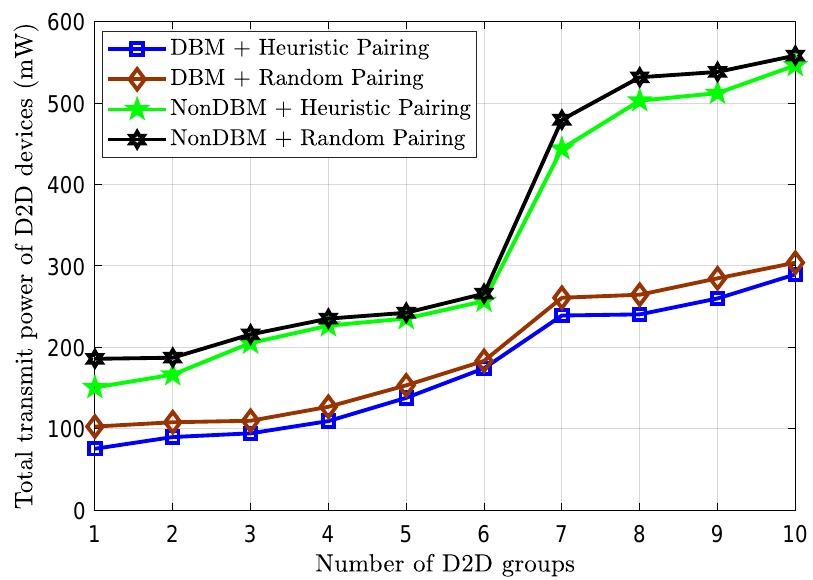
Figure 4. The total transmit power of the device-to-device communication (D2D) devices versus the number of D2D groups.